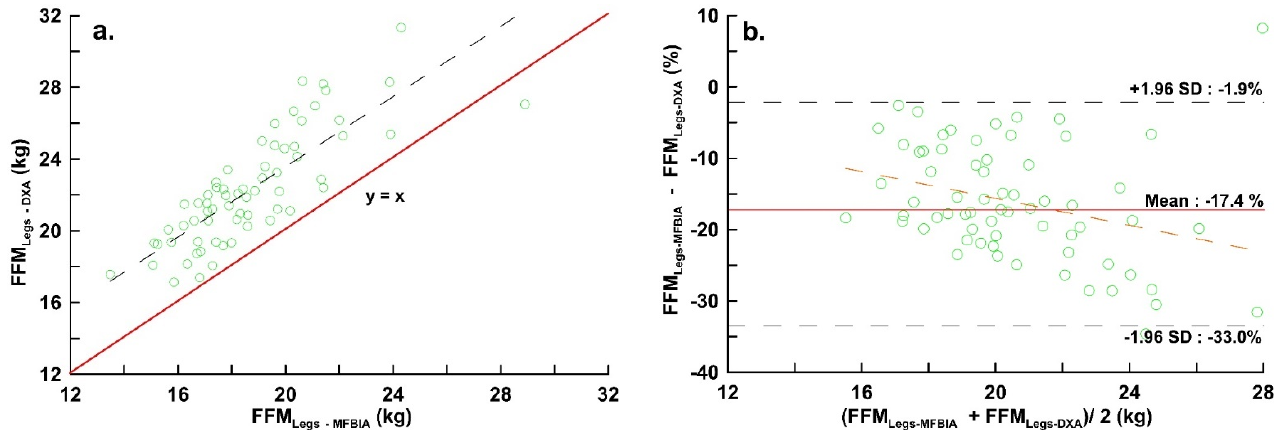
Figure 2. ( a ) Distribution of lower limbs fat-free mass measured by DXA and MF BIA (y = 3.984 + 0.979 x, r = 0.655, Residual standard deviation = 1.839, p < 0.001; ( b ) Bland–Altman Plots of lower limbs fat free mass measured by DXA and MF BIA (bias: − 17.44%, LOA: − 33.02% to − 1.87%, y = − 12.843 − 0.224 x, p = 0.366). The red line and the dotted line represent the bias and LOA respectively.